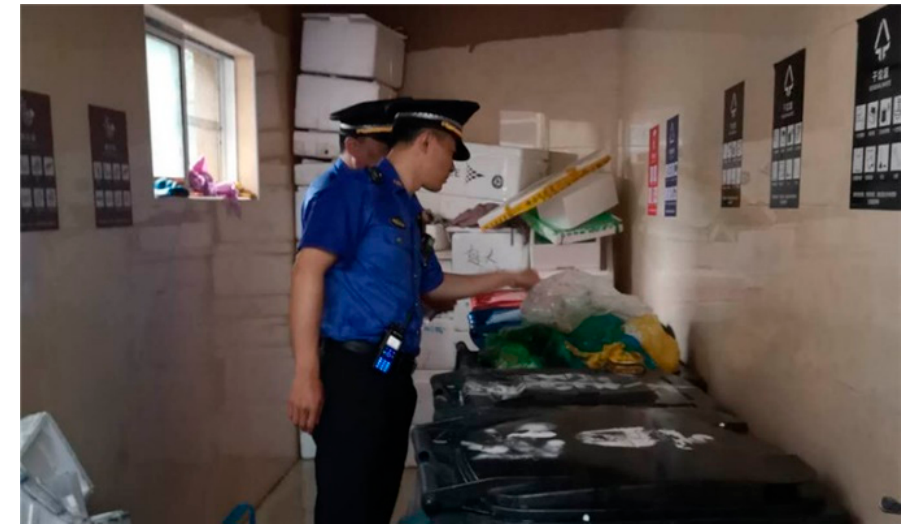
Figure 7. Law enforcement officers inspecting at a waste collection point [31].